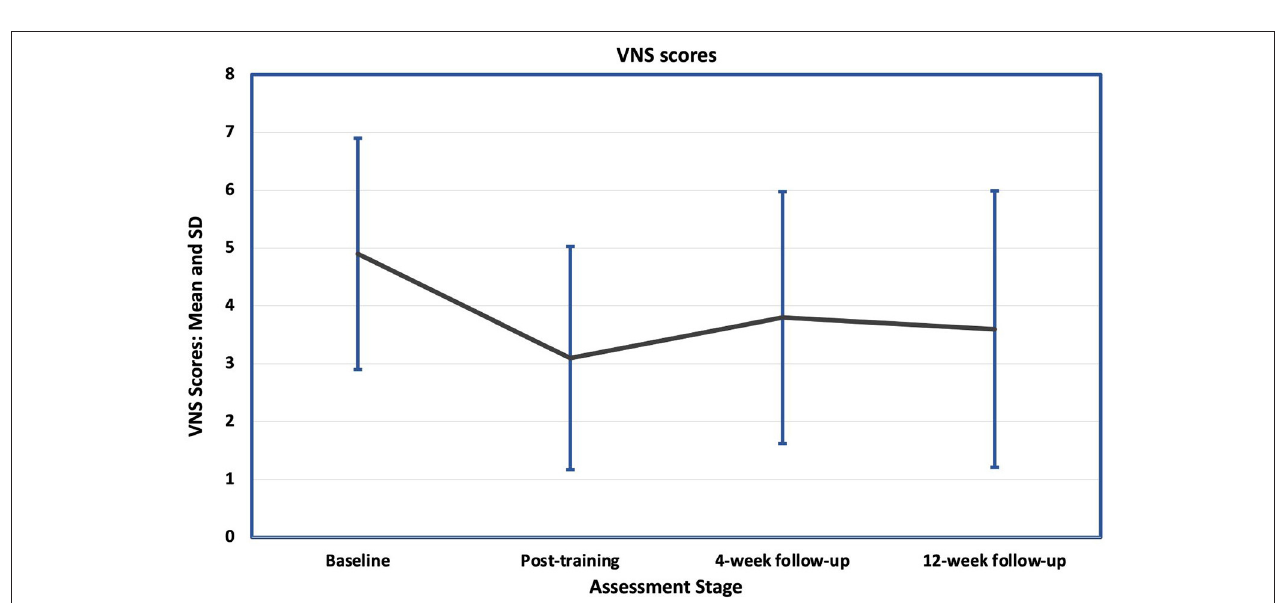
FIGURE 3 | Mean and standard deviations (SD) of the baseline and follow-up Visual Numerical Scale for pain scores (VNS) . There was a sustained fall in the mean scores at all follow-up stages, but with large standard deviations, the difference between them and the baseline mean was not significant.